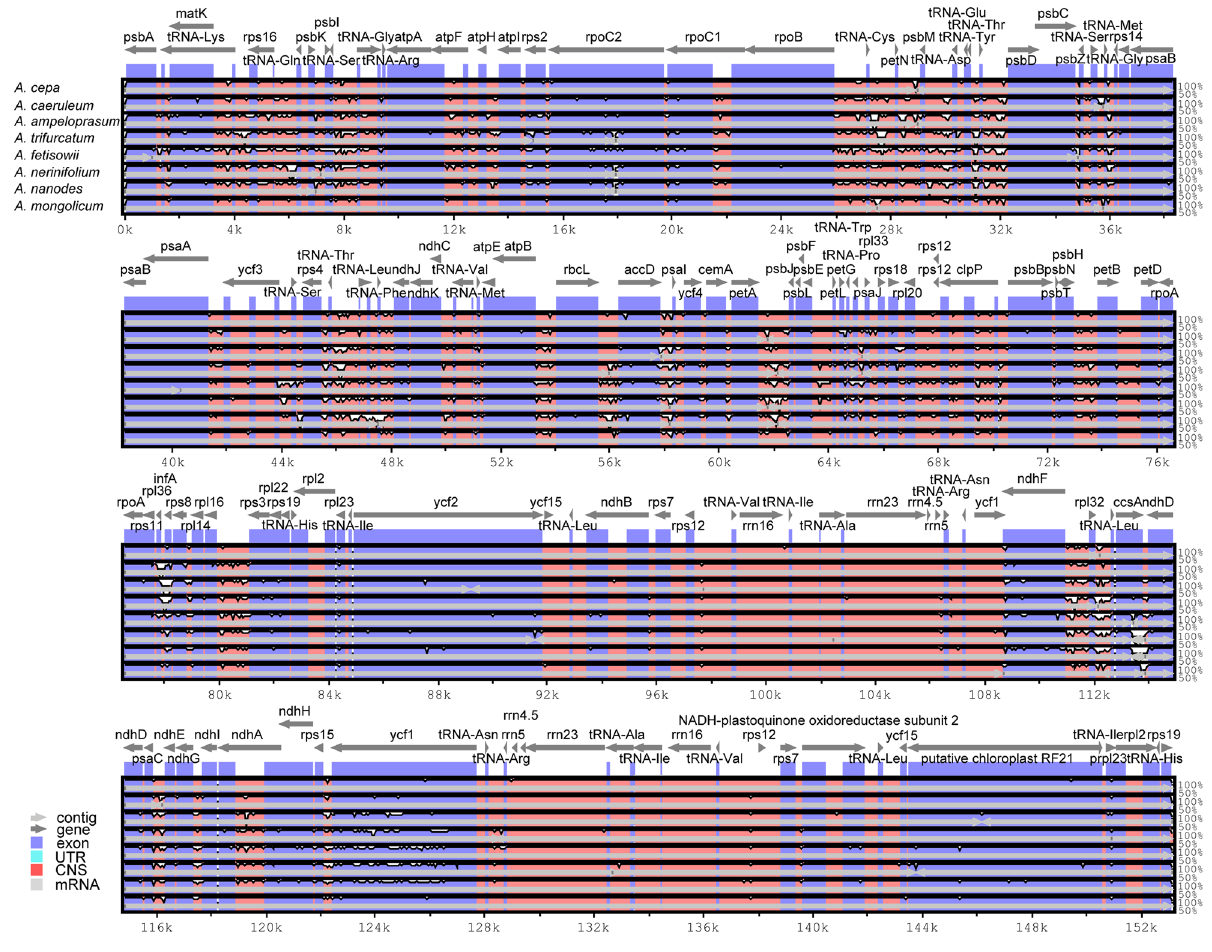
Figure 2. Sequence alignment of 9 representative Allium species using in mVISTA. The Y-scale represents the percentage of identity ranging from 50 to 100%.